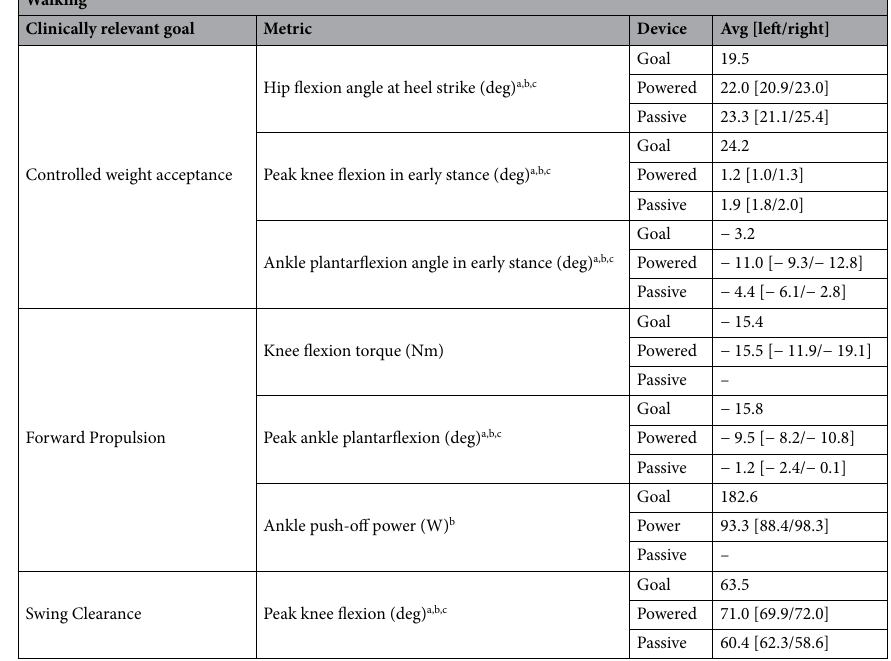
Table 1. Clinically relevant goals and metrics during walking for the powered and passive prostheses. a Statistically significant difference between powered and passive prostheses. b Statistically significant difference between powered prostheses and nonamputee reference. c Statistically significant difference between passive prostheses and nonamputee